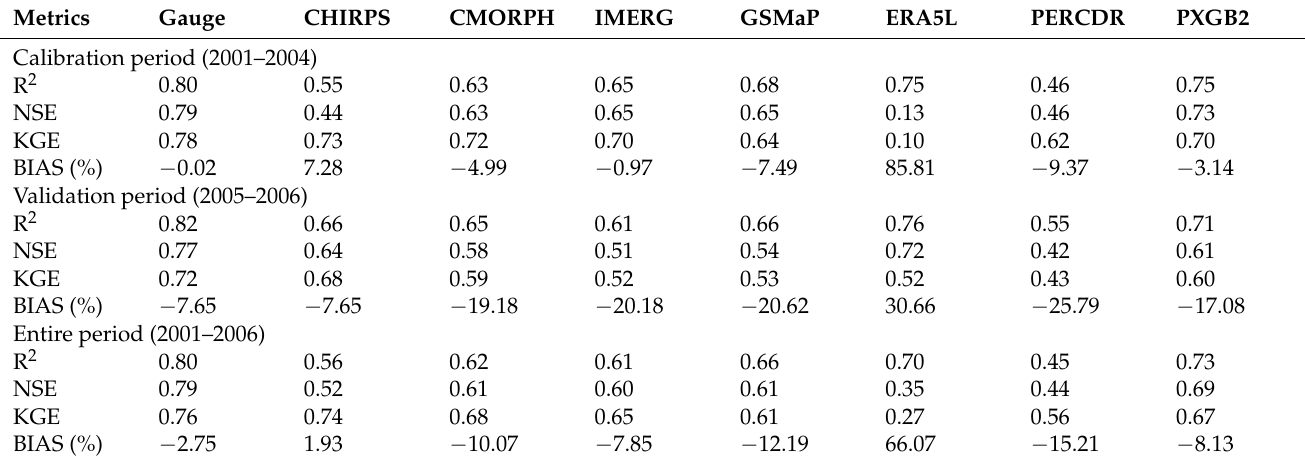
Table 6. Performance of streamflow simulation rain gauges and seven MSPs under scenario